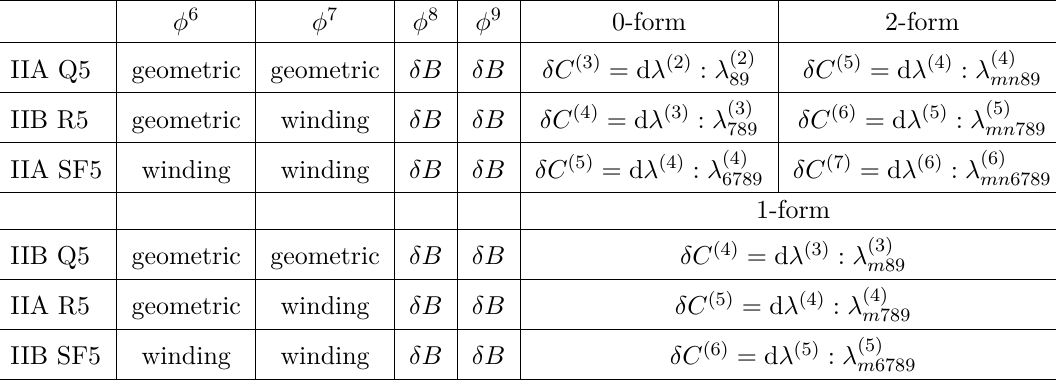
Table 3 . Physical interpretation of the zero-modes in the six-dimensional N = (2 , 0) tensor and the N = (1 , 1) vector multiplets. For the cases of the non-geometric Q5-, R5 and SF5-branes. The index structure of the gauge parameters are specified explicitly.